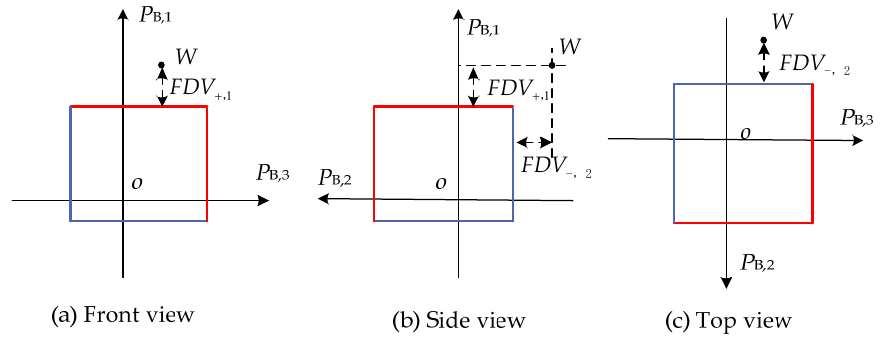
Figure 2. The three ‐ view drawing of Figure 1.